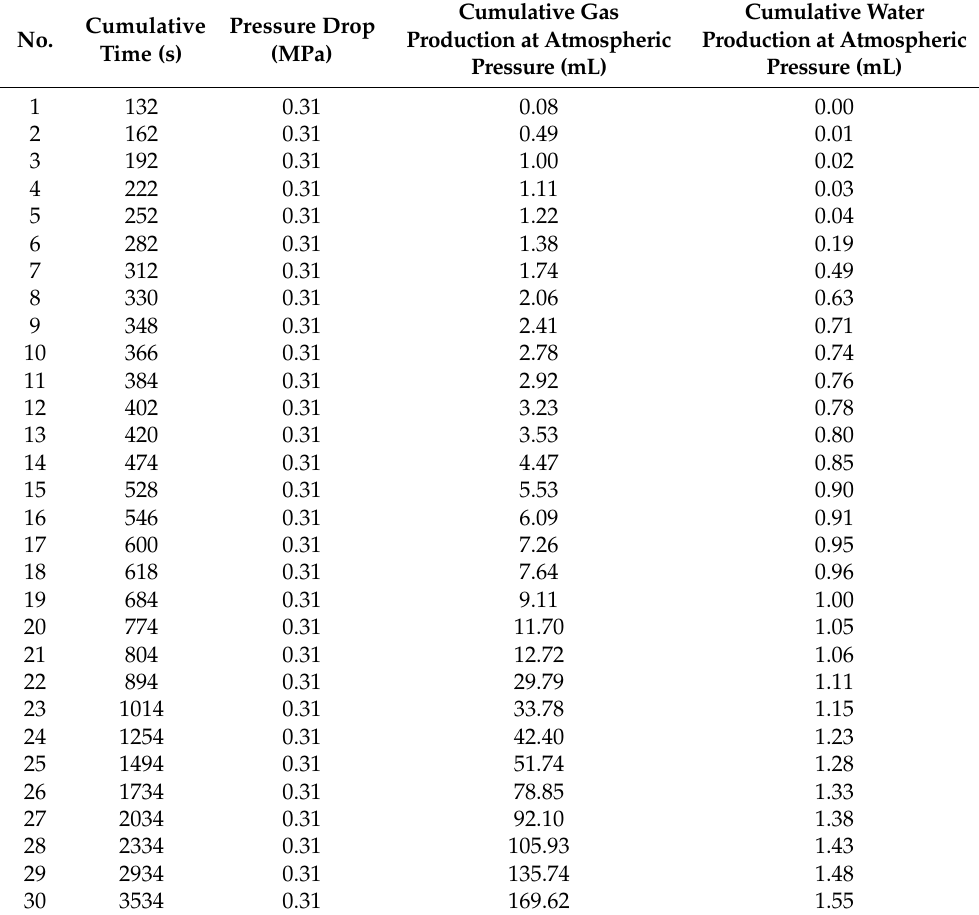
Table A1. The experimental results of No.1 (The mass of saturated water is 5.31